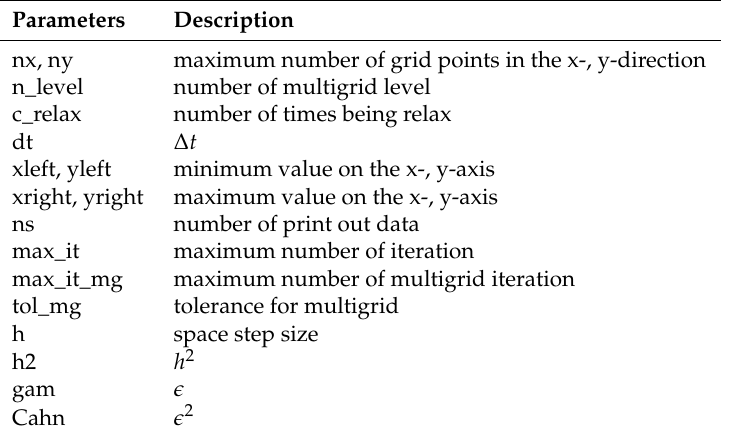
Table A1. Parameters used for the 2D Cahn–Hilliard